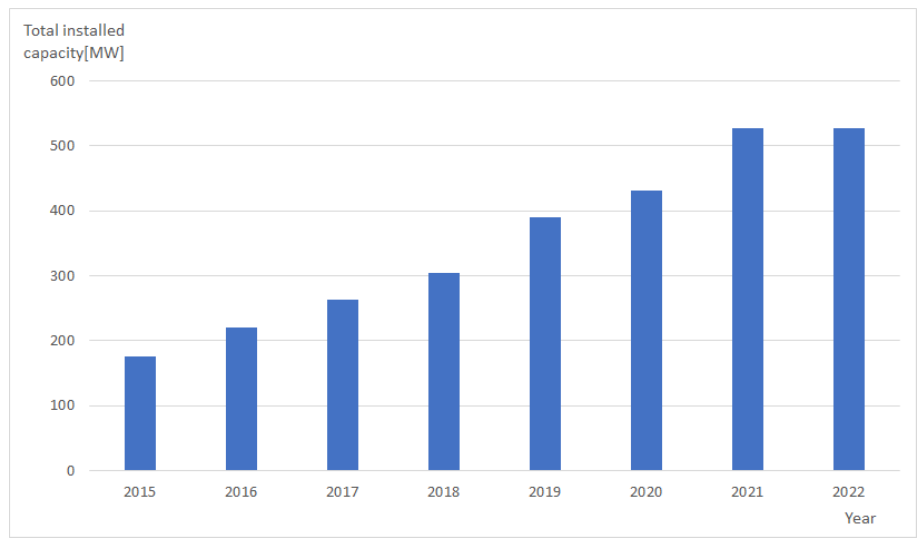
Figure 5. Production units for self-consumption installed capacity in Portugal from 2015 to 2022 (until March). Adapted from [73].